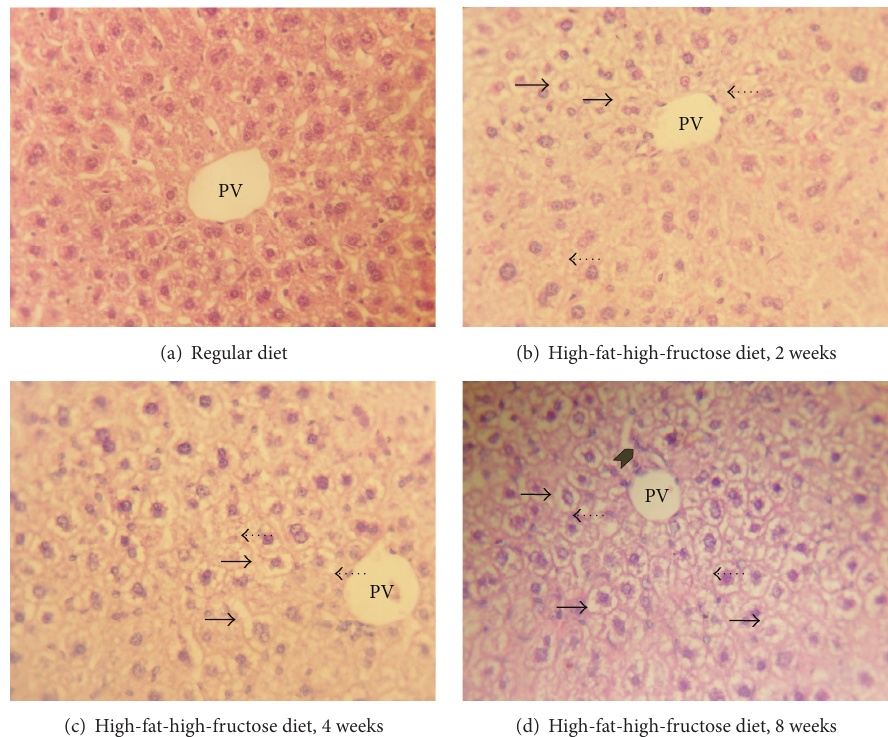
Figure 1: Histopathology of hematoxylin and eosin (H&E) stained mouse livers. The livers were collected 24 hours after the last treatment. Mice were fed a regular diet (a), or a high-fat, high-fructose diet for 2 weeks (b), 4 weeks (c), or 8 weeks (d). The micrographs are shown at a magnification of 400-fold. The solid arrows indicate sinusoidal pathology, the dash arrows indicate fat droplets, and the gray arrow indicates the foci of lobular inflammation in the liver. PV: portal